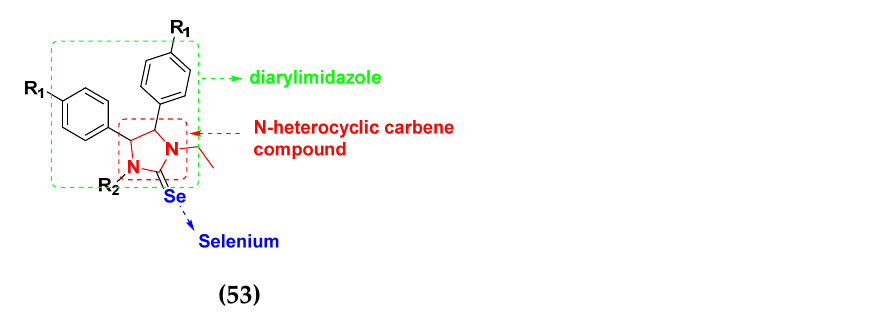
Figure 60. Structure of selenium-based diaryl imidazole hybrid derivatives ( 53 ). Table 47. In vitro cytotoxic activities of selenium based diaryl imidazole hybrid compounds 53 ( a – e ). Compounds No.